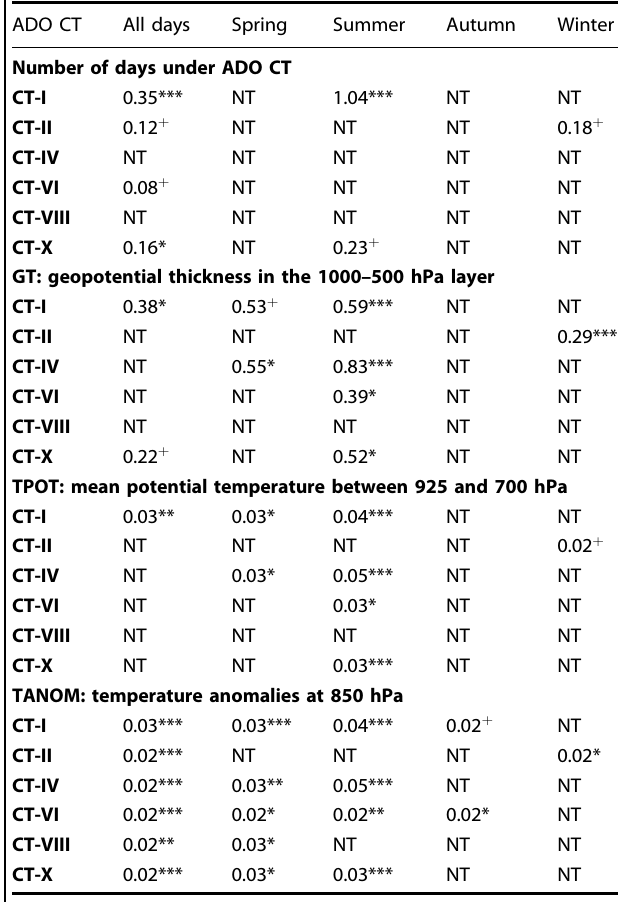
Fig 10b) the daily mean values of: